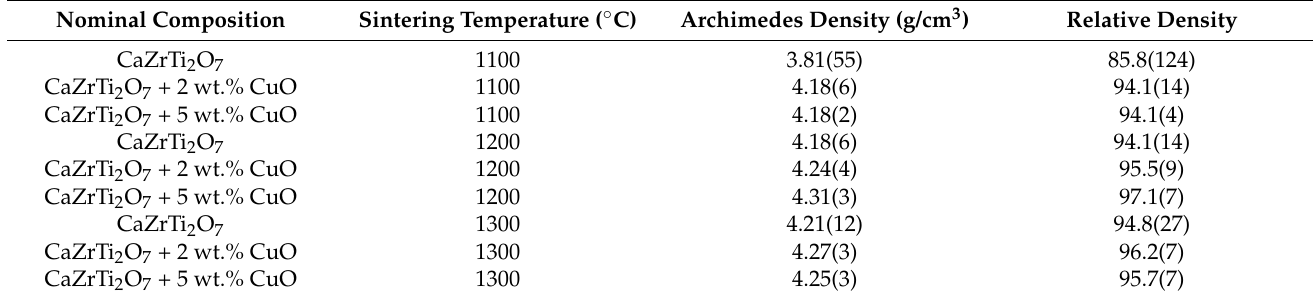
Figure 3. BSE-SEM micrographs demonstrating the effect of CuO addition on the density and phase assemblage of CuO-loaded zirconolite materials. Table 2. Archimedes density data obtained for CaZrTi 2 O 7 samples. Errors quoted are the standard deviation of five separate measurements performed for each sample. Relative density is based on the calculated density of CaZrTi 2 O 7 (4.44 g/cm 3